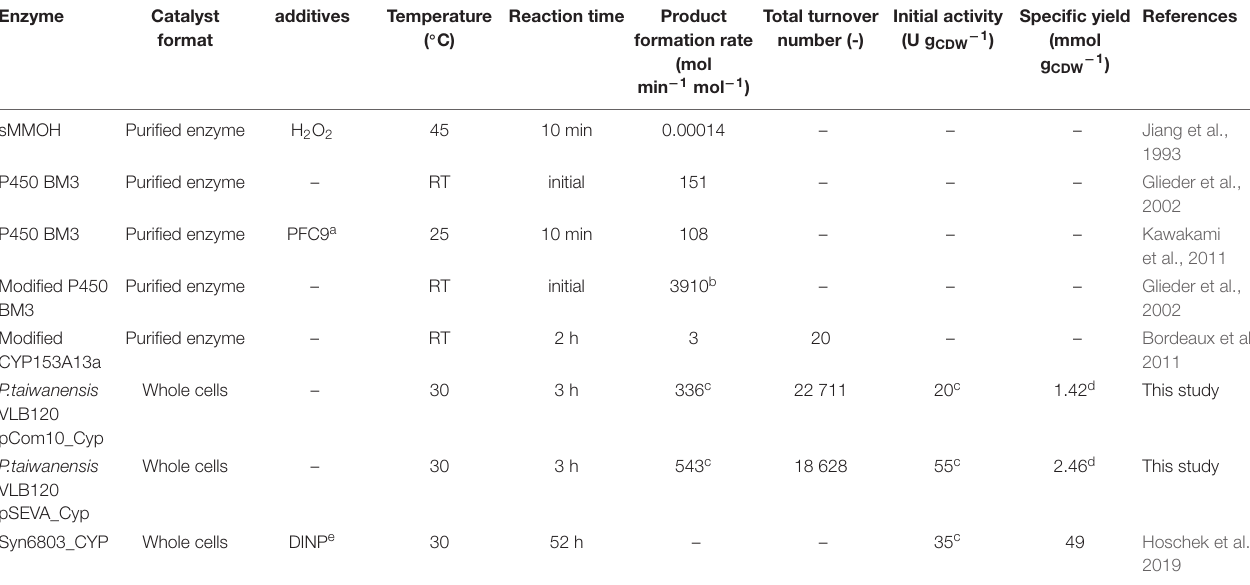
TABLE 4 | Literature data for cyclohexane